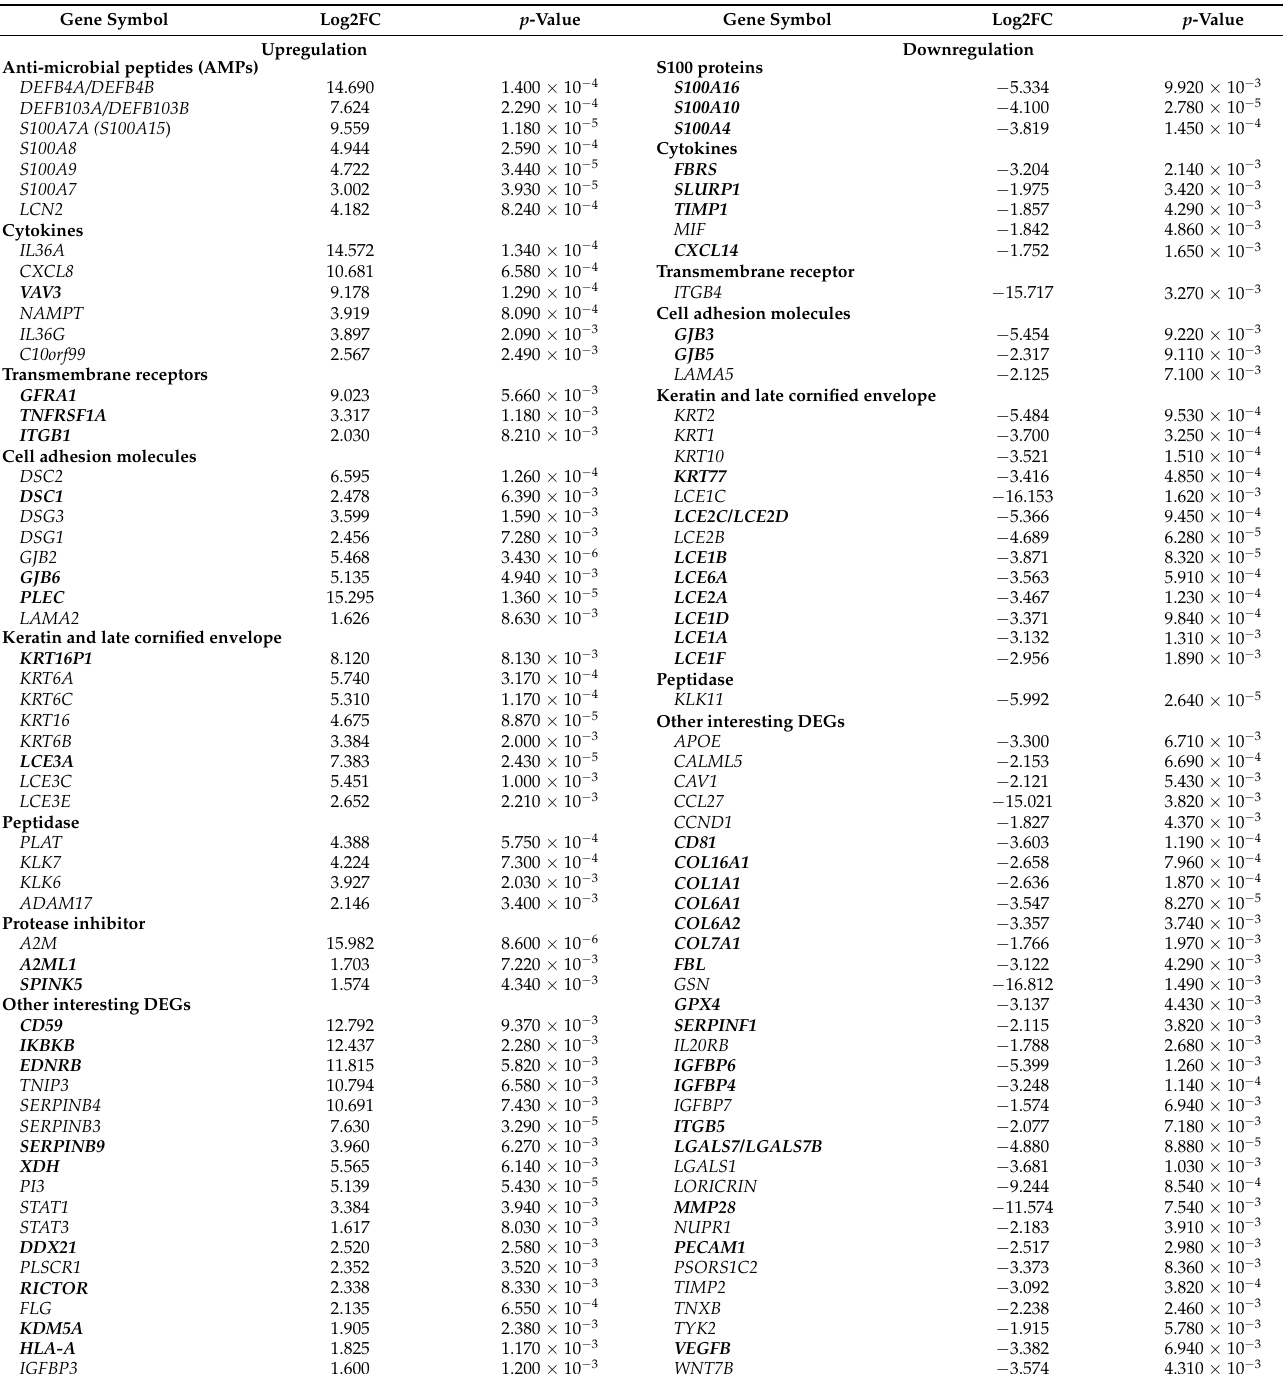
Table 2. The potential differentially expressed genes